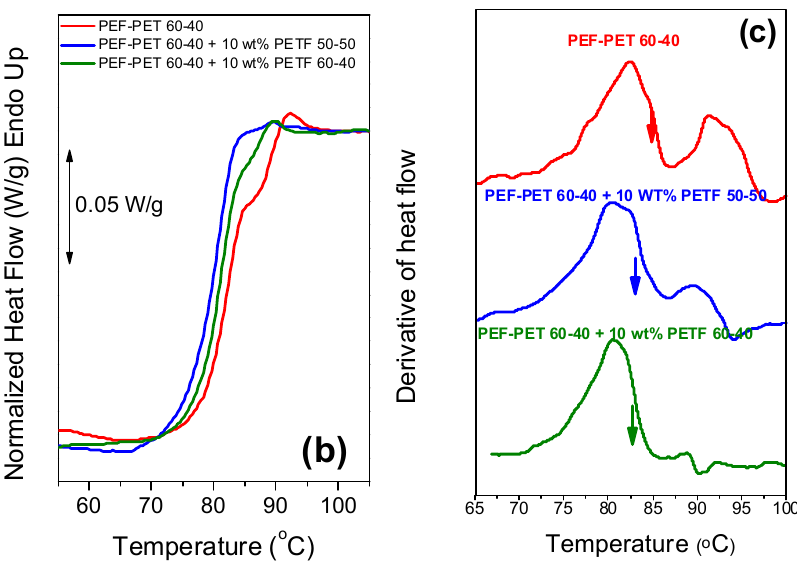
Figure 10. ( a ) DSC thermograms of the PEF–PET 60–40 blends with or without the poly(ethylene terephthalate- co -ethylene furanoate) (PETF) copolymer compatibilizer, ( b ) zoomed-in area of the glass temperature, and ( c ) derivative of heat flow for all samples under study.